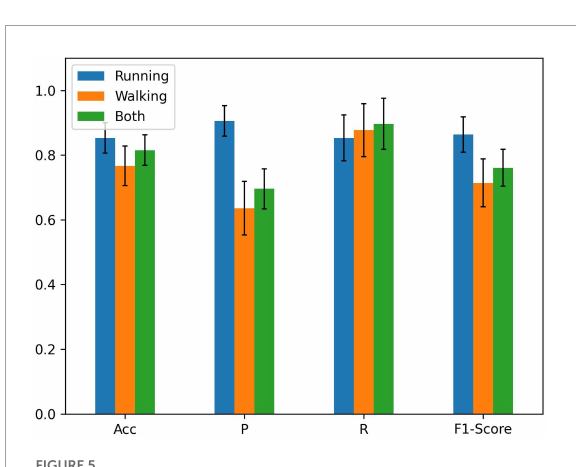
FIGURE5 Comparison of running, walking, and both as node inputs.